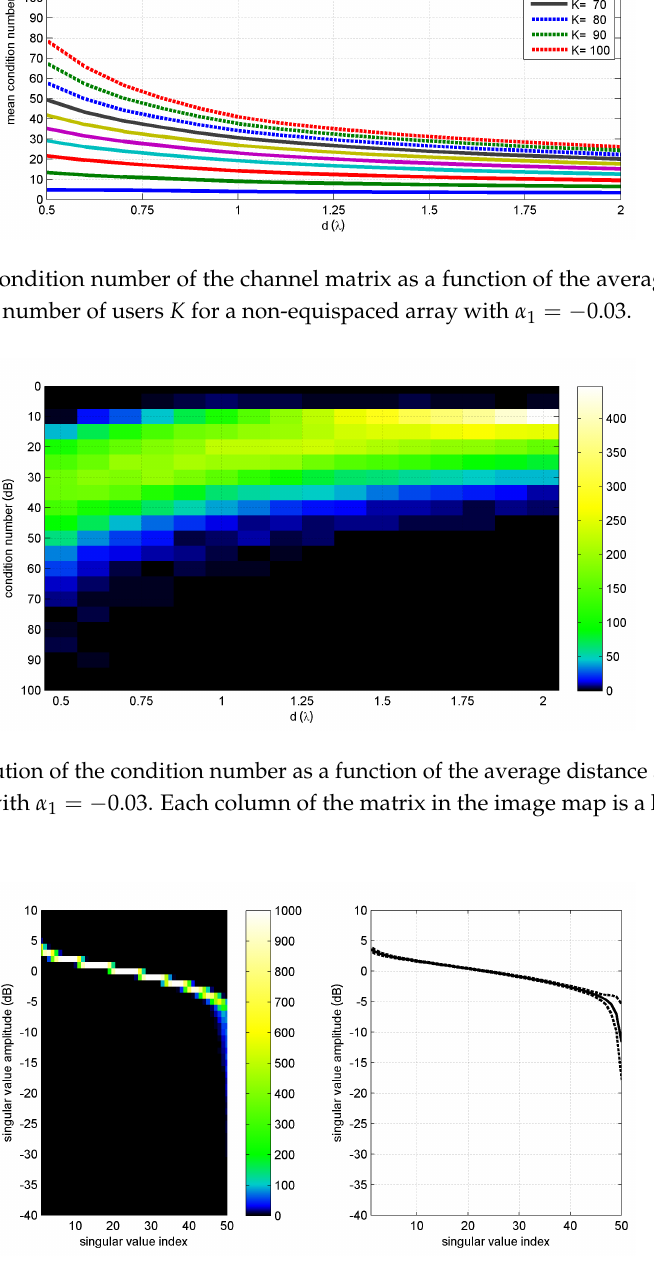
Figure 15. Singular values analysis for d 0 = 2 λ , α 1 = − 0.03 and K = 50. ( Left ) Image map of the distribution of each one of the 50 singular values; ( Right ) solid line, average singular values; dashed lines, average singular values ± the standard deviation of the